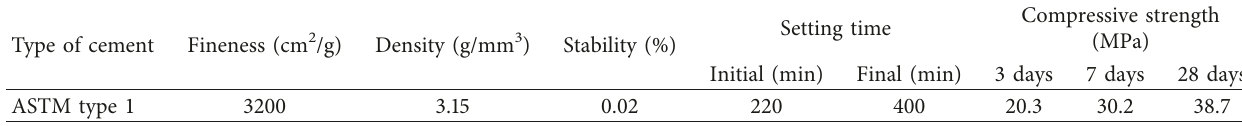
Table 1: Properties of cement.